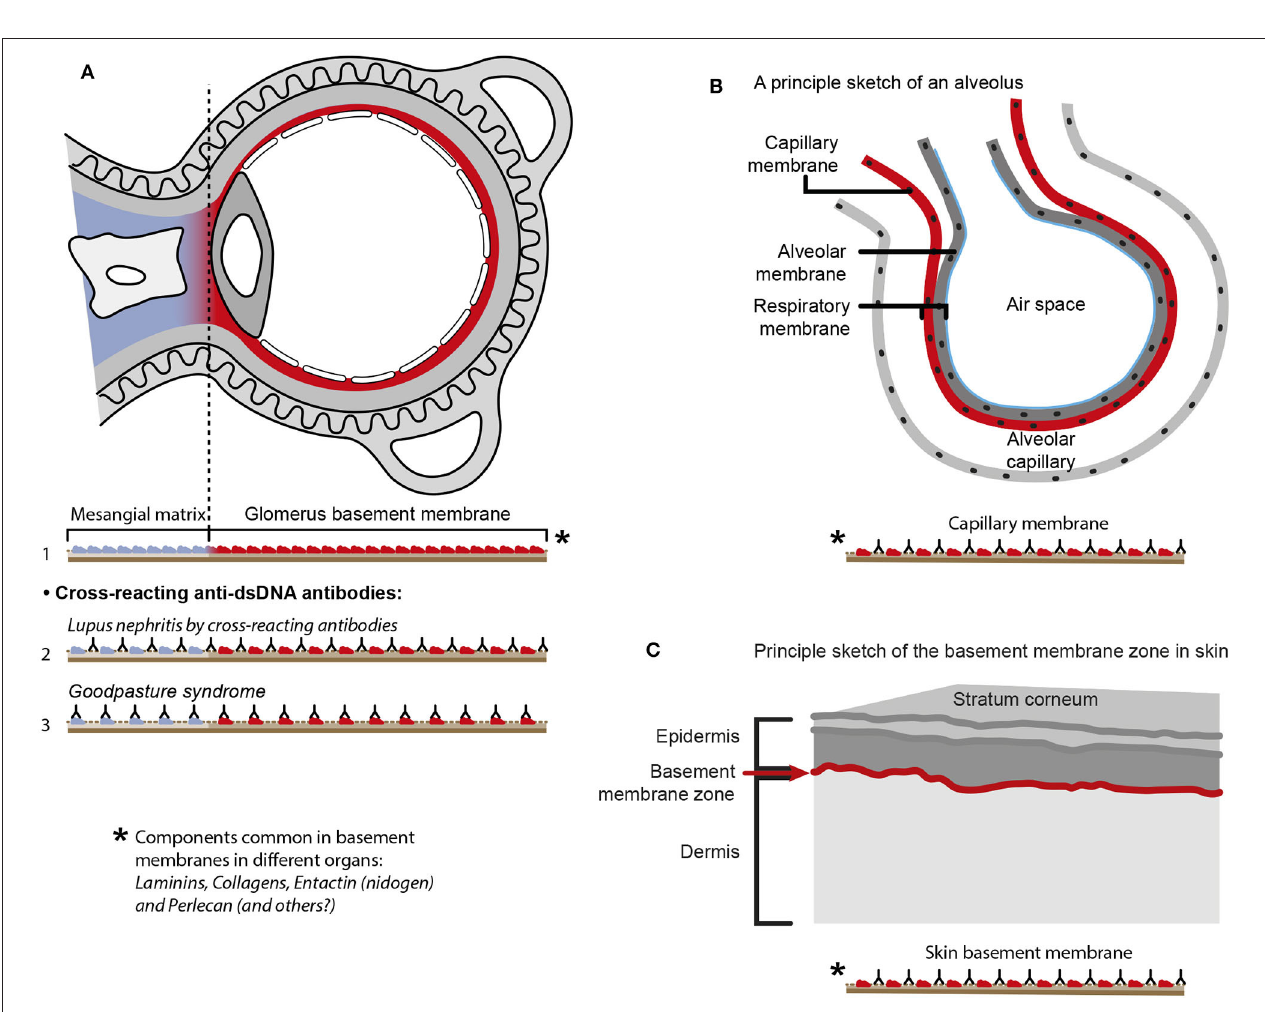
FIGURE 4 | nephritis promoted by this particular antibody incites an inflammation that down-regulates renal DNase 1 and a subsequent exposure of undigested chromatin fragments in complex with IgG anti-chromatin antibodies in GBM. This would promote the evolution of progressive lupus nephritis. In contrast to this hypothetical model, lines 5 and 6 summarize progressive lupus nephritis according to the chromatin model. These principally conflicting models are summarized in (A) , lines 2 and 3 for the chromatin model, and in (B) , line 2 for the cross-reactive model [This figure is a revised and extended version of Figure 4 in Rekvig et al. (182) with permission from Elsevier (License number 4832930988362)].